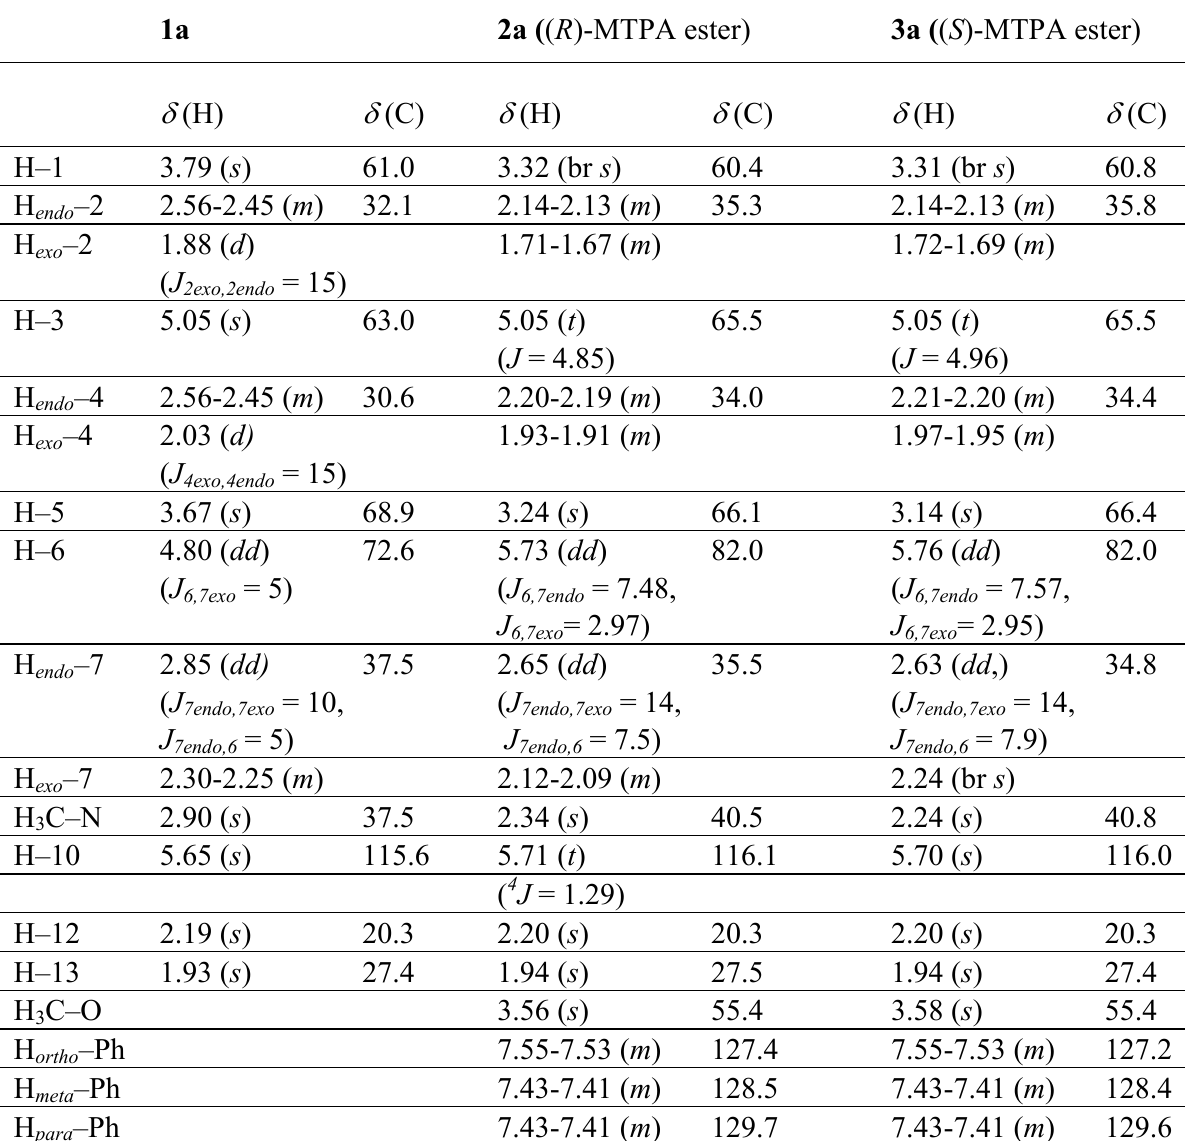
Table 1. 1 H- and 13 C-NMR data of compounds 1a , 2a and 3a in CDCl ppm, J in